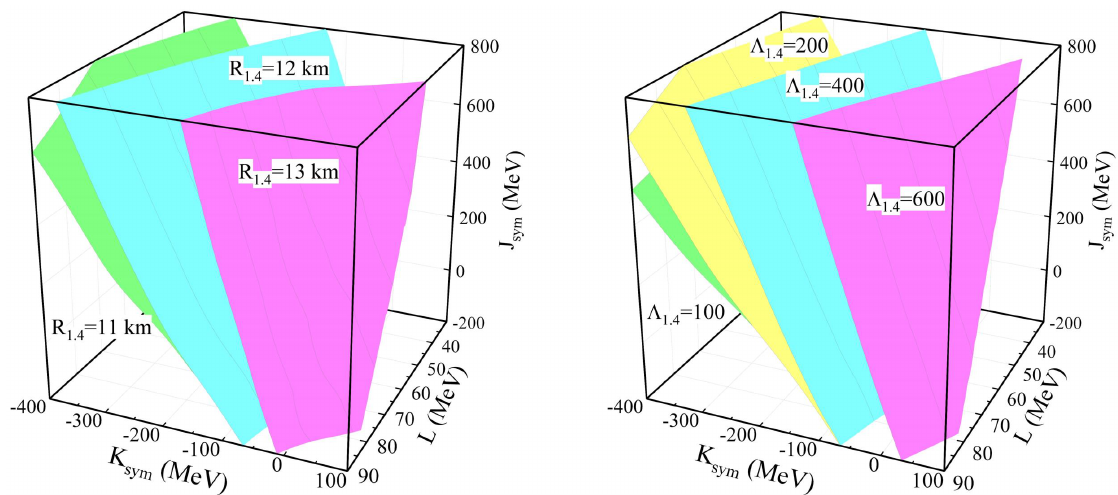
Figure 7. The constant surfaces of radius ( left ) and tidal polarizability ( right ) in the symmetry energy parameter space of L − K sym − J sym , respectively. Taken from